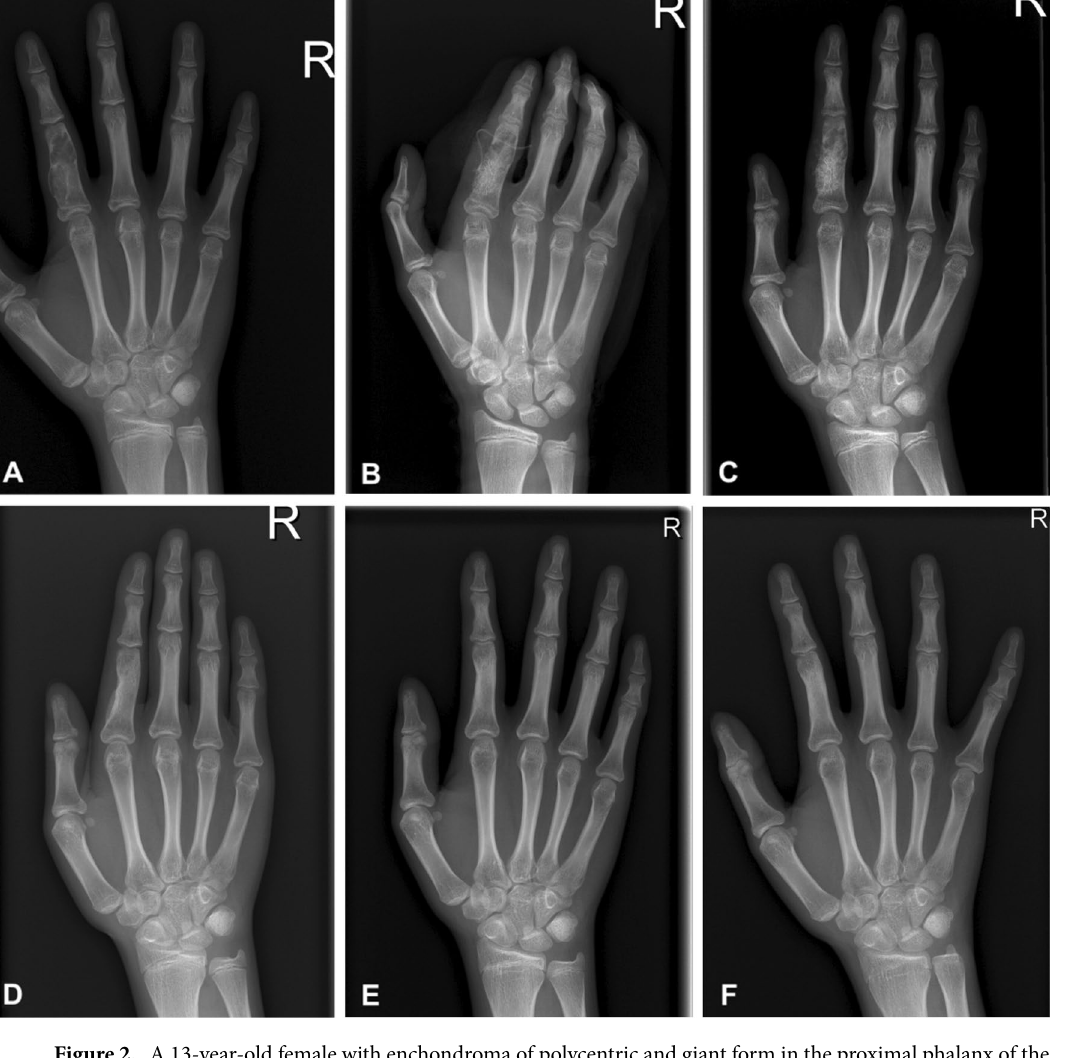
Figure 2. A 13-year-old female with enchondroma of polycentric and giant form in the proximal phalanx of the right index finger. Simple radiographs taken before surgery ( A ), immediately ( B ), 1 month ( C ), 2 months ( D ), 1 year ( E ), and 9 years ( F ) after